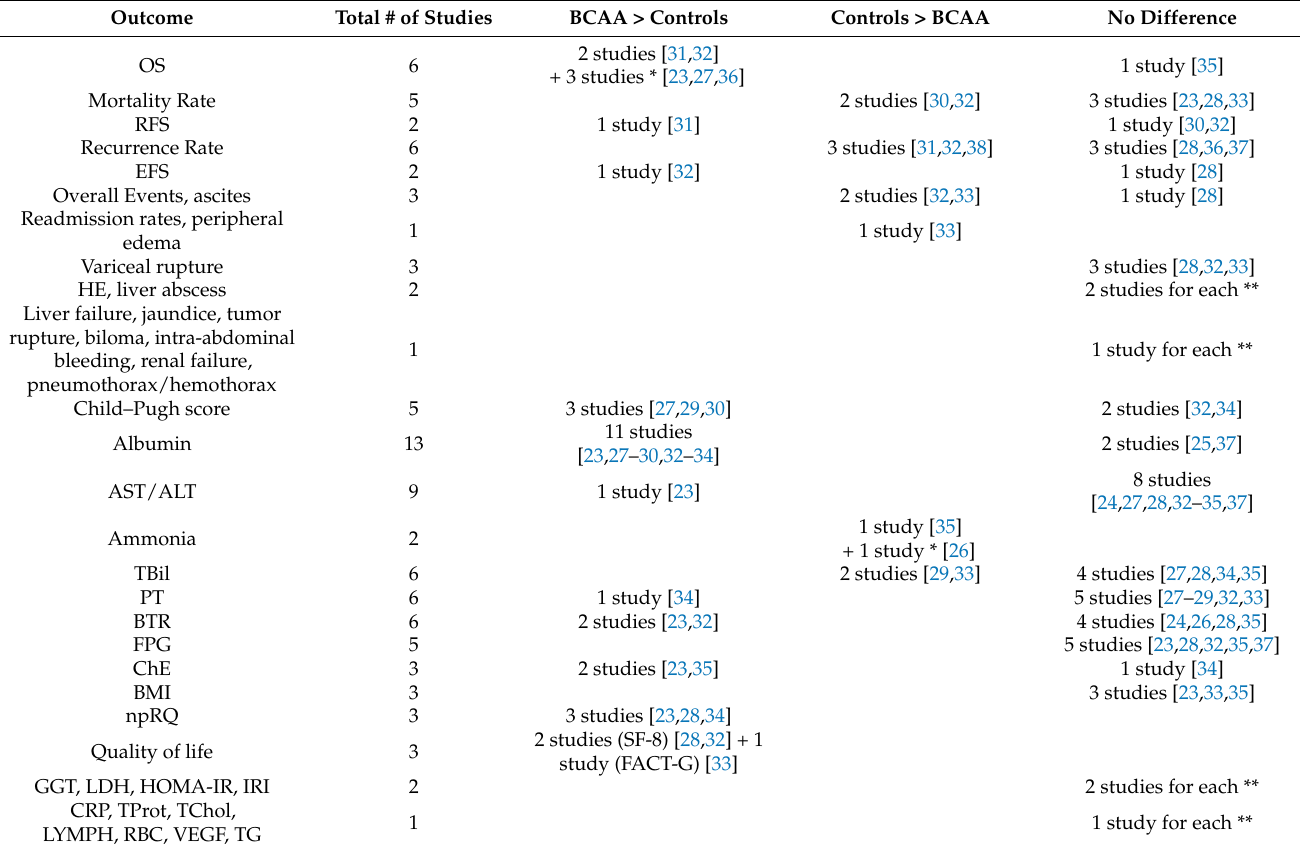
Table 4. Summary of